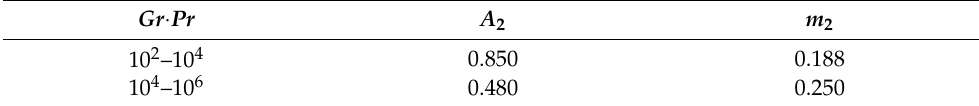
Table 2. Values of the product Gr · Pr